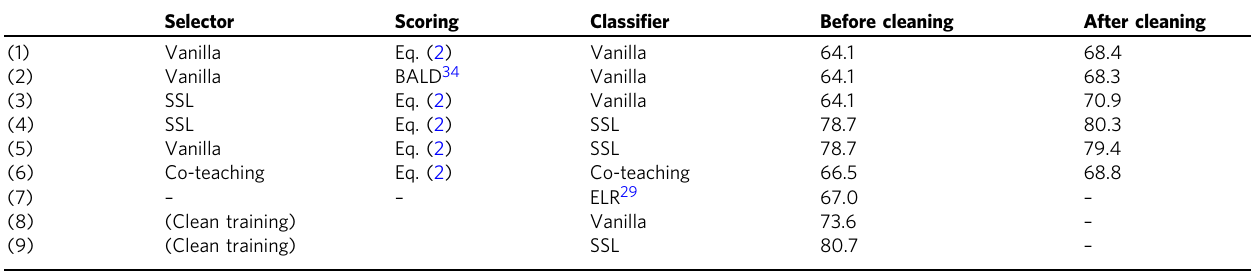
Table 1 Classi fi cation accuracy (%) before and after label